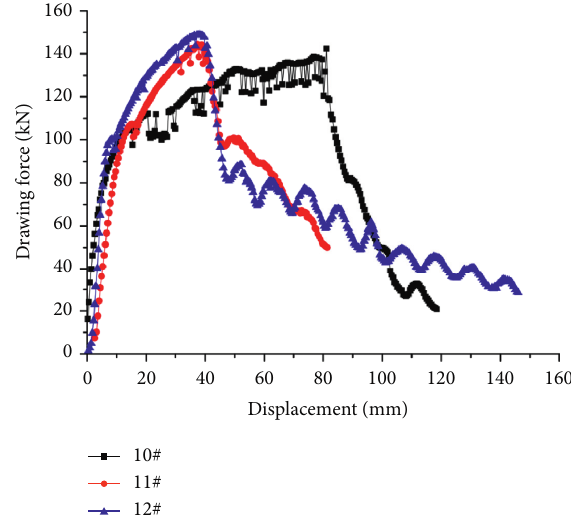
Figure 9: Drawing force of screw steel bolt (anchorage 300mm). Table 2: Summary of pull-out force of bolt with different anchorage